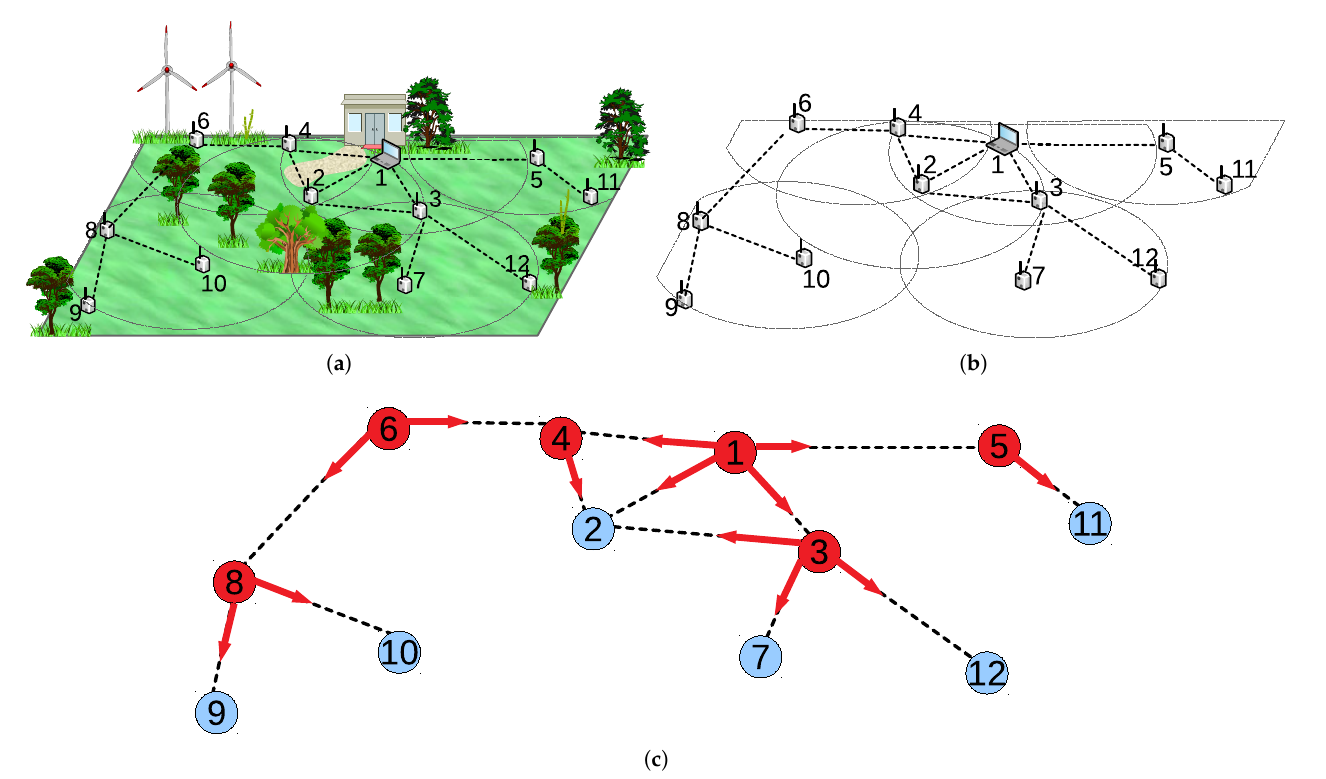
Figure 1. An example of link monitoring application for the vertex cover problem: ( a ) Deployment of a sample WSN; ( b ) Graph represantation of the topology; ( c ) Link monitoring application on the